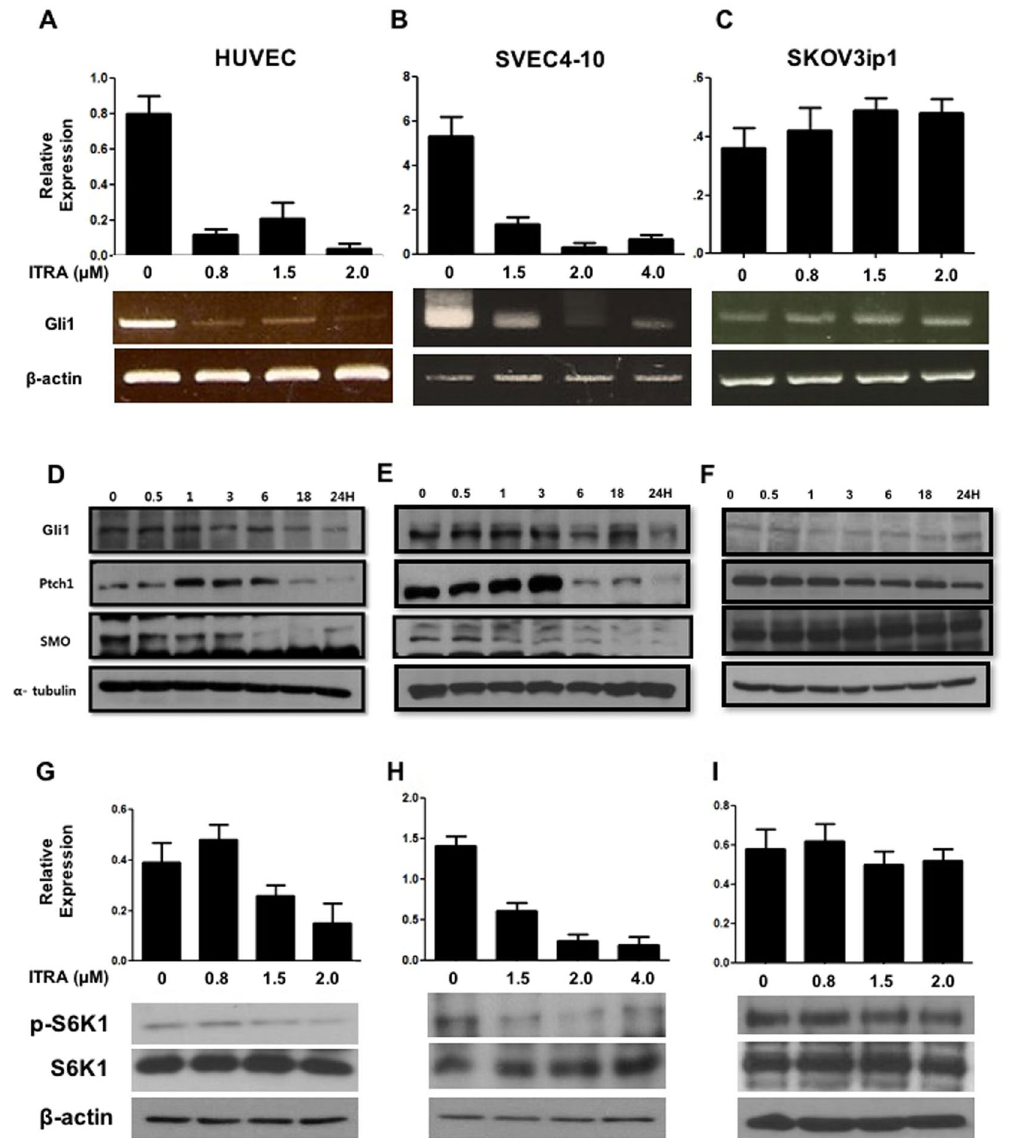
Figure 3. Inhibition of hedgehog and mTOR pathways by itraconazole. The expression of Gli1, Ptch1, and SMO, which are central for the activation of hedgehog signaling, was tested in HUVEC ( A and D ), SVEC4-10 ( B and E ), and SKOV3ip1 ( C and F ) cells. Cells were treated with ITRA and processed in the same manner as in Fig. 2. The molecules were inhibited by itraconazole in endothelial cells, but levels of these molecules did not change in SKOV3ip1 cells. mTOR inhibition was determined based on the phosphorylation status of the substrate S6 kinase (S6K) after treatment with itraconazole as determined by Western blot in HUVEC ( G ), SVEC4-10 ( H ), and SKOV3ip1 ( I) cells. Itraconazole inhibited the phosphorylation of S6K1 in a dose- dependent manner in endothelial cells ( A and B ), while no inhibition was observed in ovarian cancer cells. The gels images were cropped and full-length gels and blots are included in the Supplementary Figure